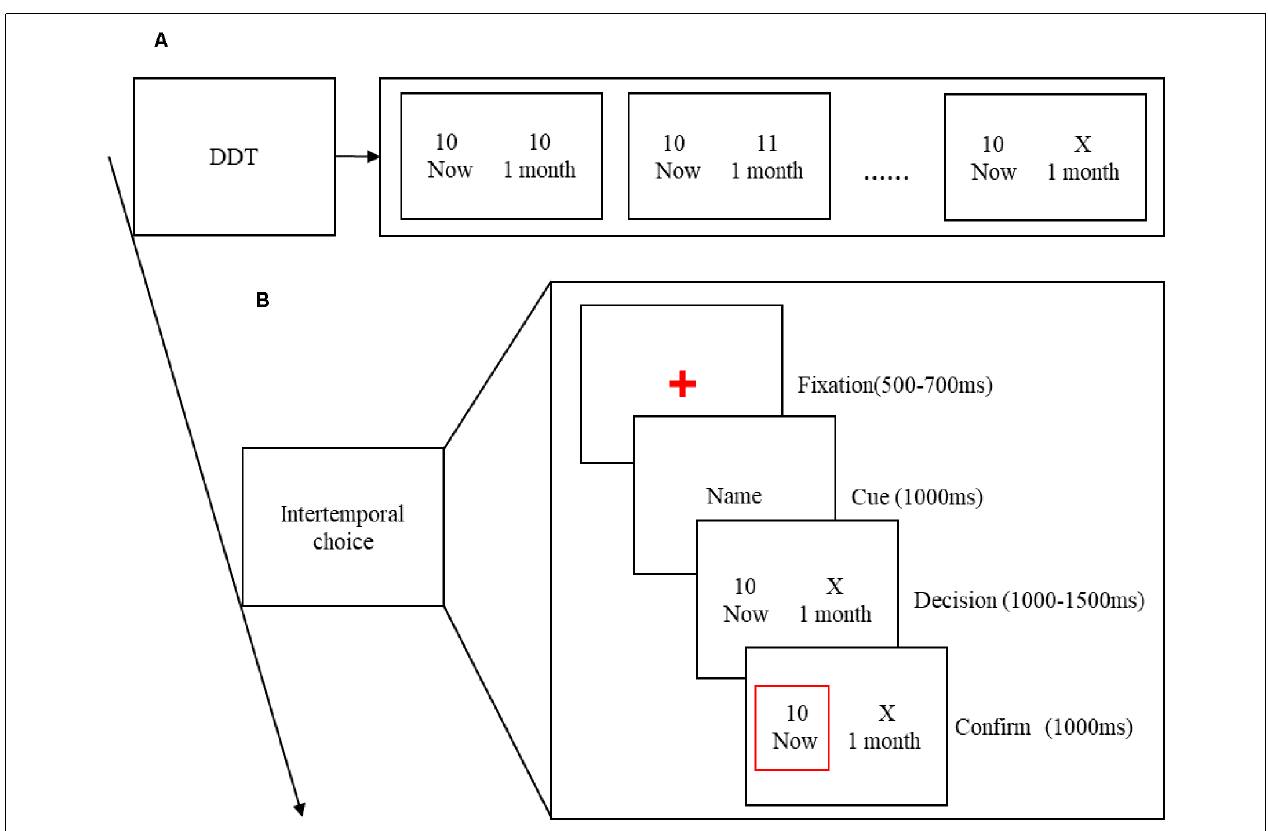
FIGURE 1 | (A) The process of the Delayed Discount Task (DDT). (B) Time course of a single trial. Each trial began with a red fixation, randomized between 500 and 700 ms. Followed by the name of decision-maker for 1,000 ms. Then, the participant’s indifferent intertemporal choice presented at a random time